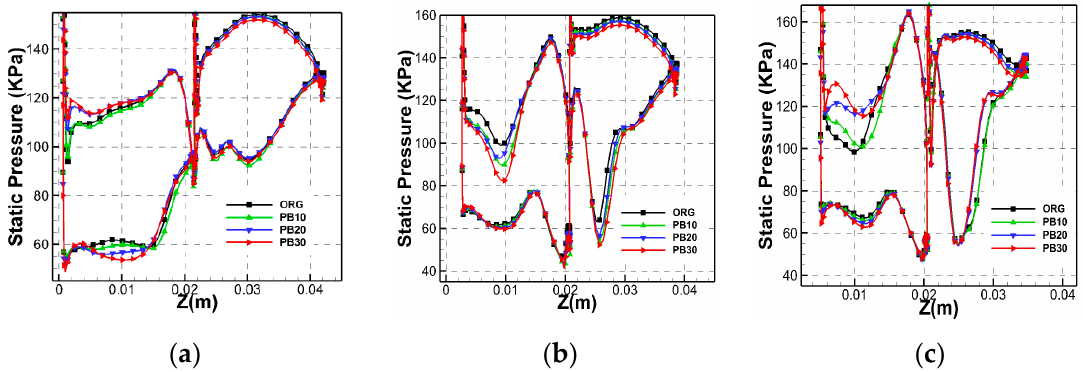
Figure 18. Comparison of surface static pressure at different spans of PB10, PB20, and PB30. ( a ) 10% span. ( b ) 50% span. ( c ) 90% span.